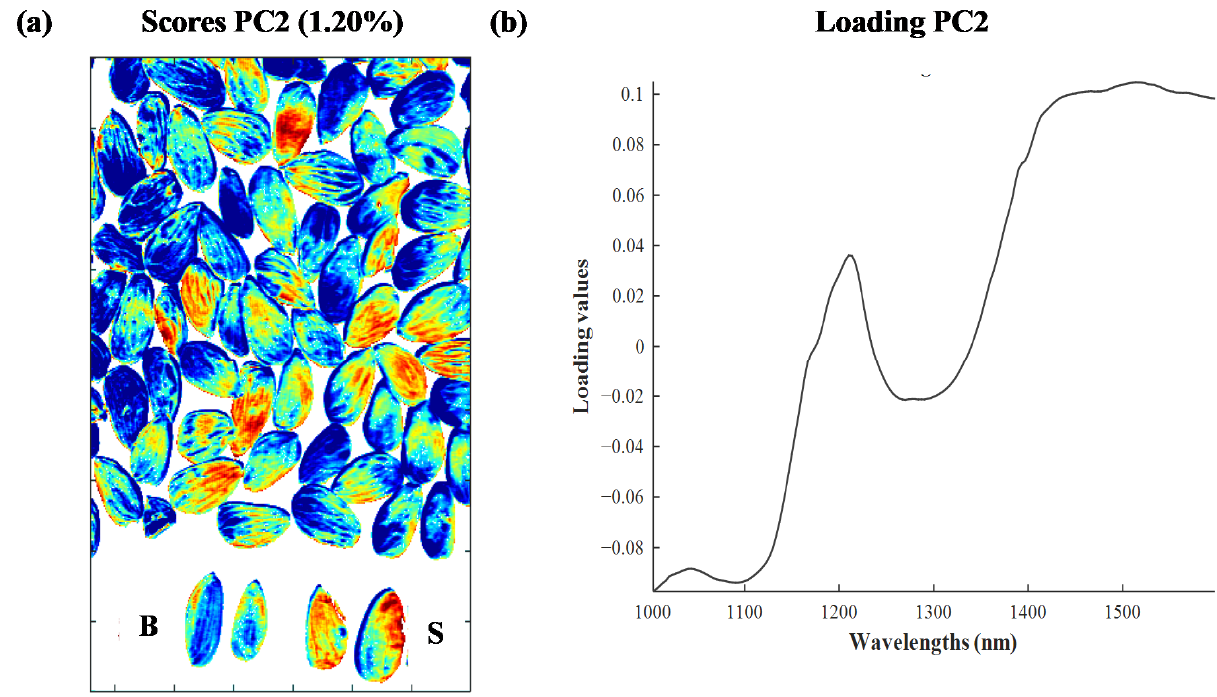
Figure 2. Score image ( a ) and loading plot ( b ) for the second principal component of the mixtures.